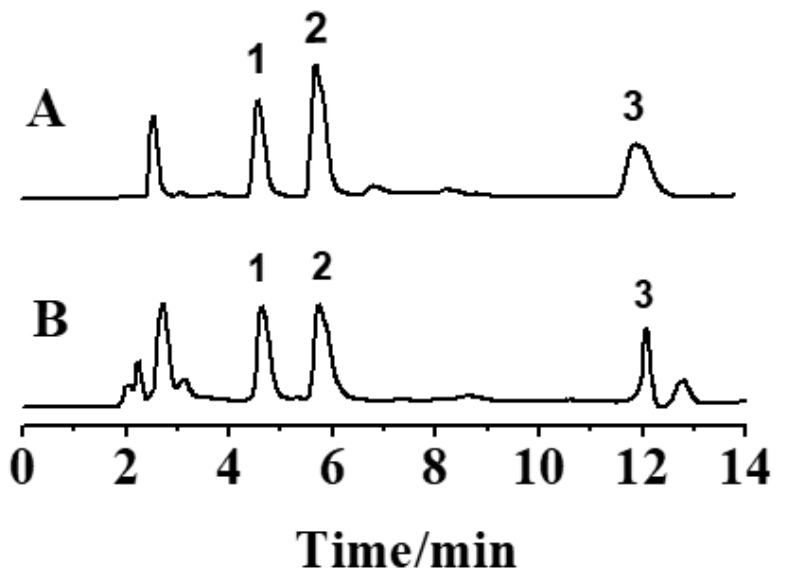
Figure 4. ( A ) HPLC-DAD chromatogram of mixing CPMP-monosaccharide standards; ( B ) HPLC- DAD chromatogram of PCP s after derivatization; (peak 1, CPMP-Gla, t R = 4.78 min; peak 2, CPMP- Glc, t R = 5.92 min; peak 3, CPMP-Man, t R = 12.03 min.). Table 3. Determination of monosaccharide composition of Table 3. Determination of monosaccharide composition of PCP s.